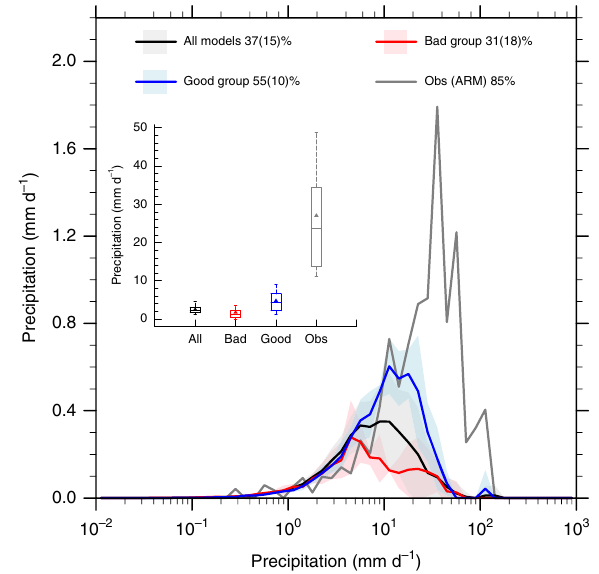
Fig. 3 Daily precipitation distribution. Distribution of daily precipitation for all models, good group, bad group, as well as that observed by Atmospheric Radiation Measurement (ARM) Program during 1996 – 2005 at the SGP site. The inset plot is the boxplot of daily precipitation. The boxes indicate the 10%-quantile, 25%-quantile, median, 75%-quantile, and 90%-quantile, respectively. Solid triangles stand for the mean